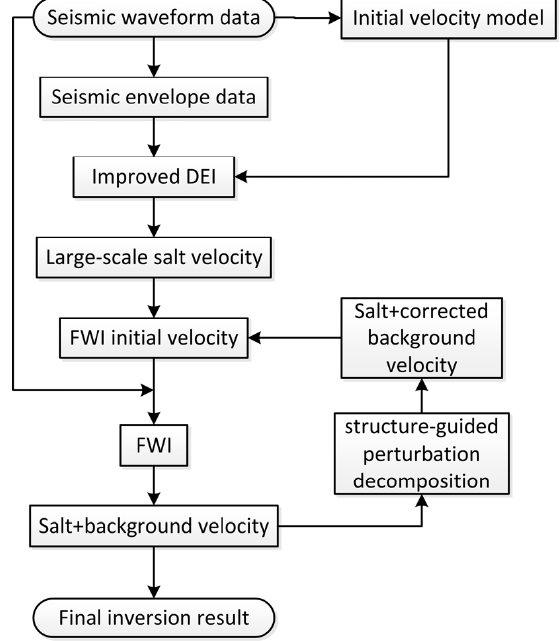
Figure 3. The workflow of SGPD inversion strategy.